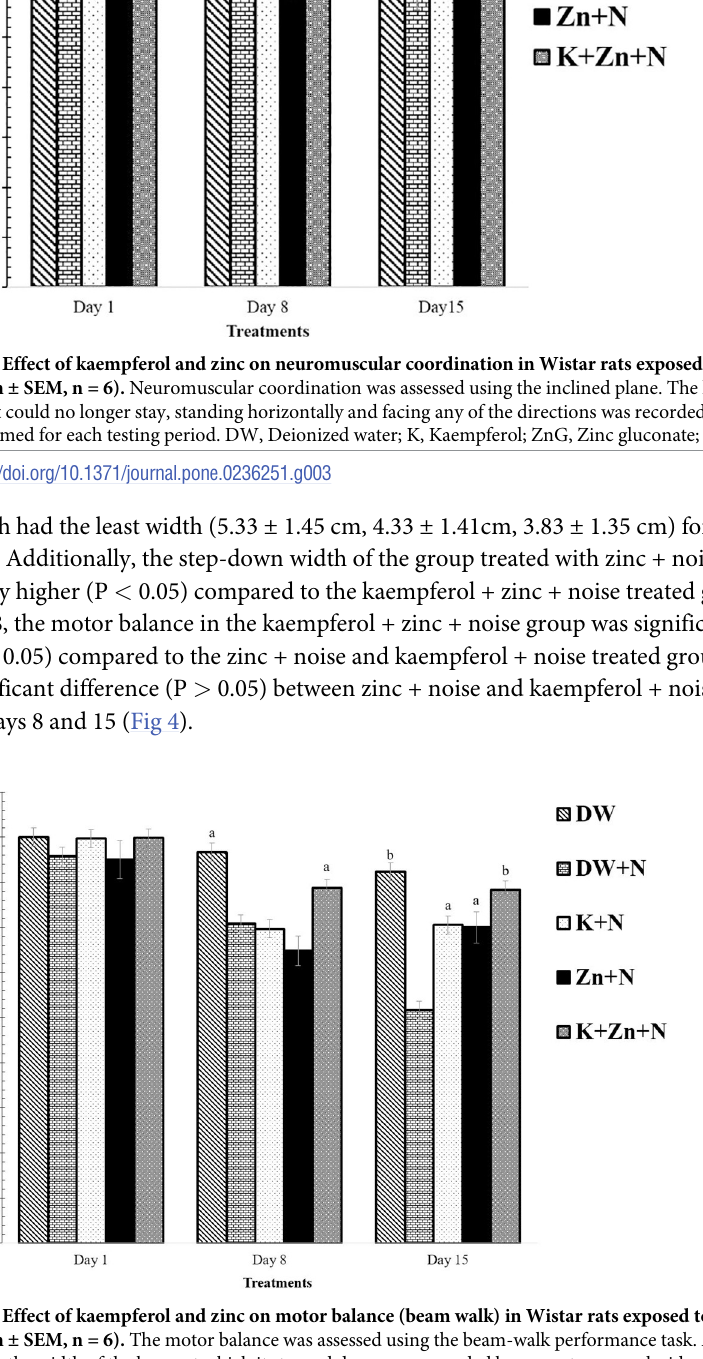
Fig 4. Effect of kaempferol and zinc on motor balance (beam walk) in Wistar rats exposed to noise stress (Mean ± SEM, n = 6). The motor balance was assessed using the beam-walk performance task. As the rat walked across, the width of the beam at which it stepped down was recorded by one rater on each side, and this was repeated twice during each trial session. a P < 0.05, b P < 0.01, c P < 0.001, is significantly different compared to control group (DW+N). � P < 0.05, is significantly different compared to K + Zn + N group. DW, Deionized water; K, Kaempferol; Zn, Zinc gluconate; N, Noise.